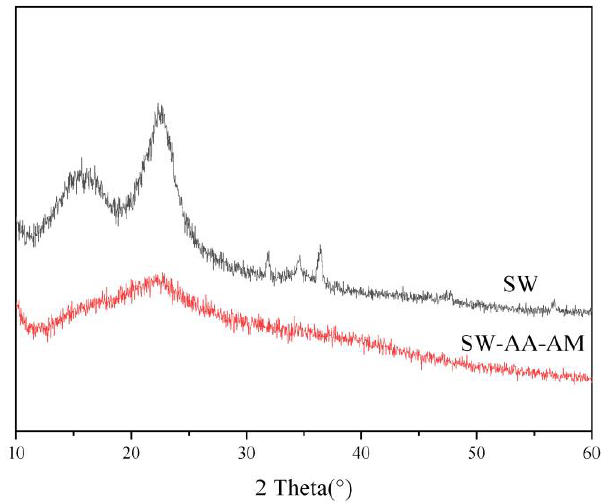
Figure 2. XRD patterns of sawdust and the SW-AA-AM polymer.